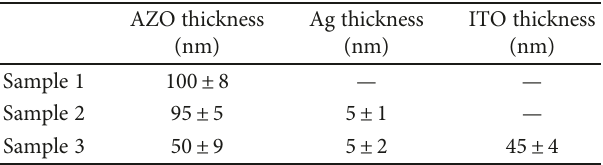
Table 1: The thickness and error range of AZO, Ag, and